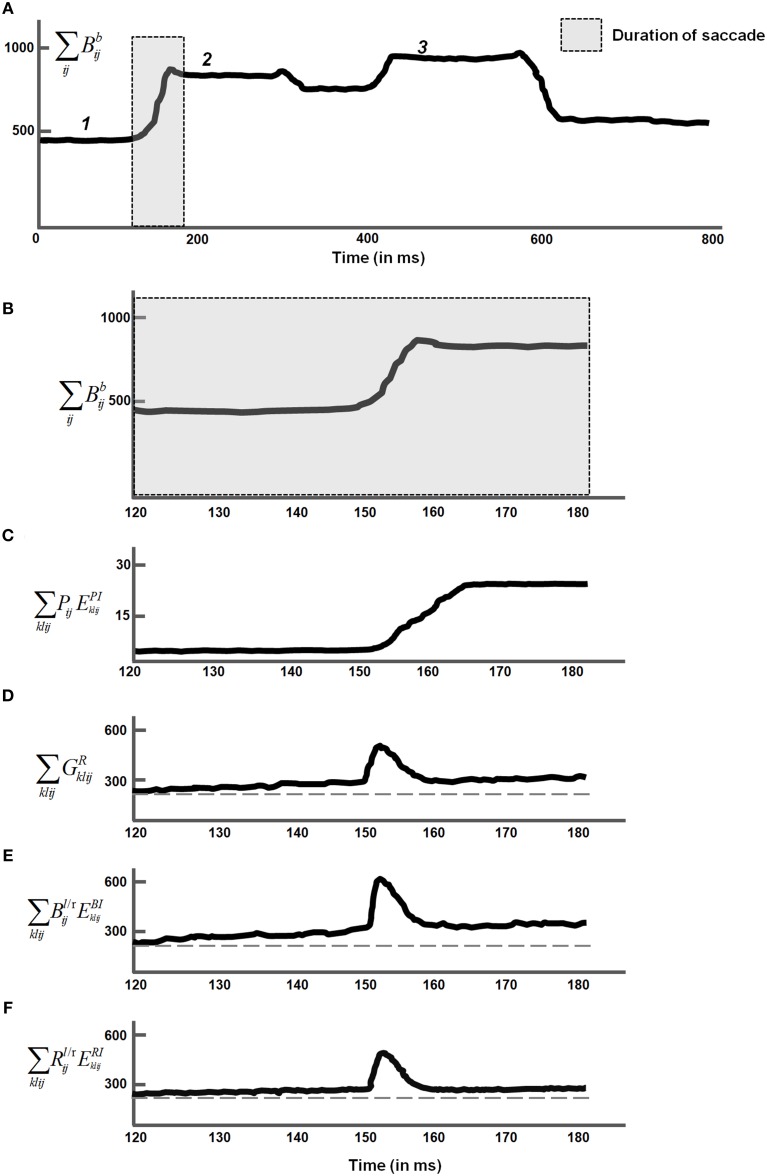
Predictive remapping of fused invariant binocular boundaries. The input stimulus is the same as in Figure 9 and the paradigm is from Figure 10. The maintained fusion of boundaries is demonstrated when saccades are made to target positions within one object, in this case, the soccer ball. For convenience, only ON channel (+) responses are shown. The OFF channel (−) responses look similar and thus the +/− superscripts are dropped for convenience. (A) Temporal evolution of the fused invariant binocular boundaries ∑ijBbij (Equation 33) when saccades are made within the soccer ball. The markings “1,” “2,” and “3” correspond to the target positions on the surface contour map shown in Figure 10. The dashed gray box is the duration of the saccade (60 ms) for which the dynamics are presented in (B–F). (B) Temporal evolution of the invariant binocular boundaries ∑ijBbij before, during, and after an eye movement to target position “2” in Figure 10 following fusion of the invariant monocular boundaries. The dotted gray box shown covers the duration of the saccade shown in (A). Even before the eye movement is completed, there is predictive remapping of the fused boundaries by the boundary gain fields. (C–F) show the boundary gain field activity for the left eye (l). The right eye profiles are the same. To achieve predictive remapping of the invariant left monocular boundary, the invariant left monocular boundary gain fields GLlklij (Equation 28) are activated by top-down inputs ∑ijBlij
EBIklij from invariant left monocular boundaries (Equation 26), eye position signals ∑klijPij
EPIklij (Equation 66), and bottom-up inputs ∑klijRlij
ERIklij from retinotopic left monocular boundaries (Equation 22). (C) Temporal profile of the eye position input ∑klijPij
EPIklij. ((D) Temporal evolution of the summed invariant left monocular boundary gain field activity ∑klijGRlklij. (E) Temporal profile of the invariant left monocular boundary input ∑klijBlij
EBIklij. (F) Temporal evolution of the retinotopic left monocular boundary input ∑klijRlij
ERIklij. The gray dotted lines in (D–F) show the change in activity from baseline. See Section 4.4 for details.